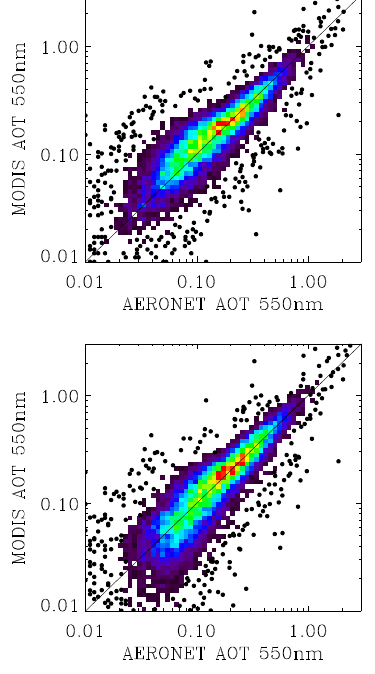
Fig. 9. Density plots of MODIS Aqua AOT vs. AERONET AOT for the original (top) and corrected (bottom)